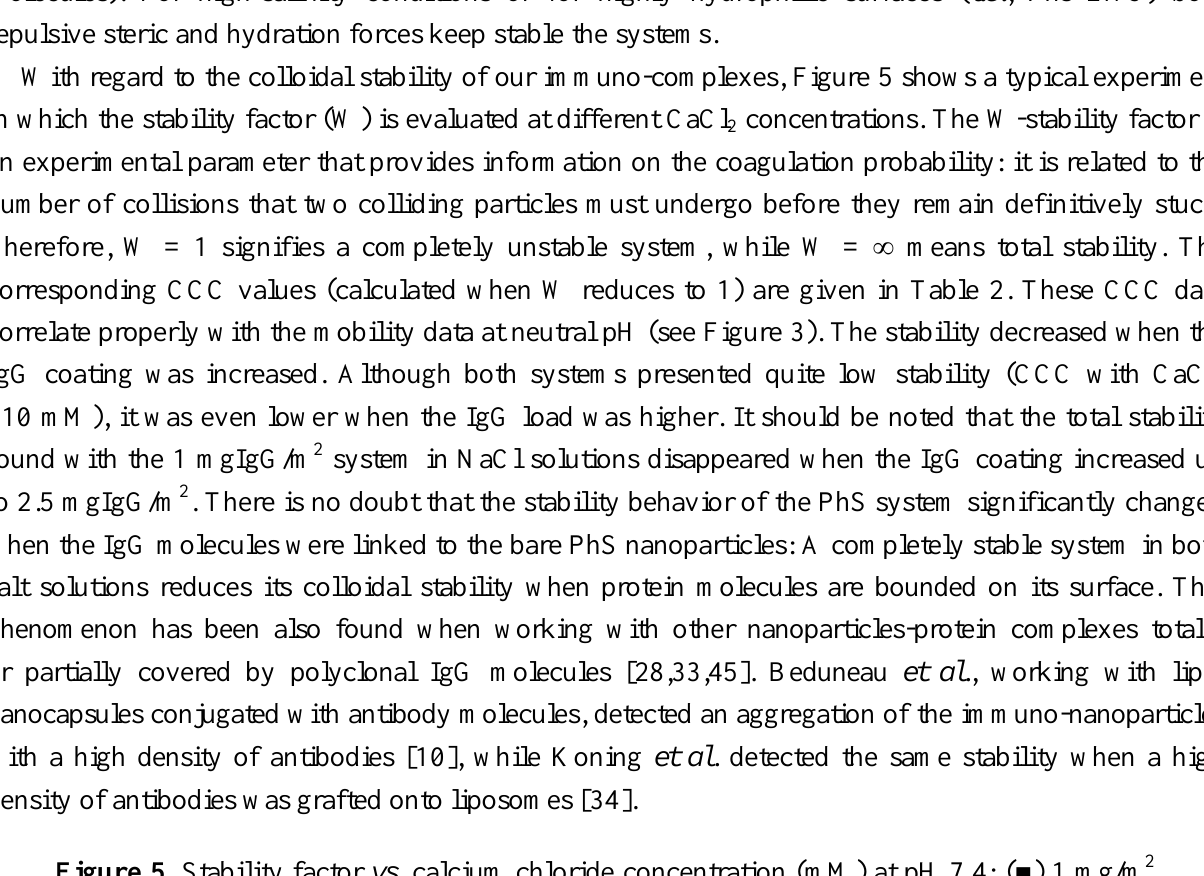
Figure 5. Stability factor vs. calcium chloride concentration (mM) at pH 7.4: (■) 1 mg/m 2 IgG-PhS; (●) 2.5 mg/m 2 IgG-PhS. Solid lines help to locate the CCC values, while dashed lines point to the CSC